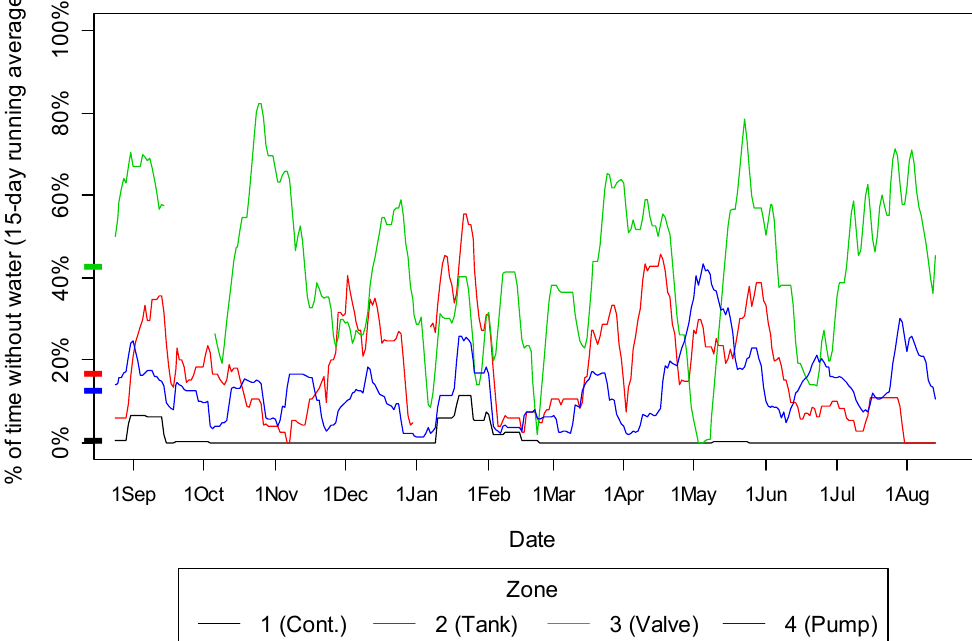
Figure 6. Fifteen-day running average of the percent of time that supply was off in each zone. For each day, the average percent of time water was off during the 15 nearest days is shown. Values are only shown if at least 7 days (out of 15) of data were available. Colored dashes on the y-axis mark the average percent of time water was off in each zone.